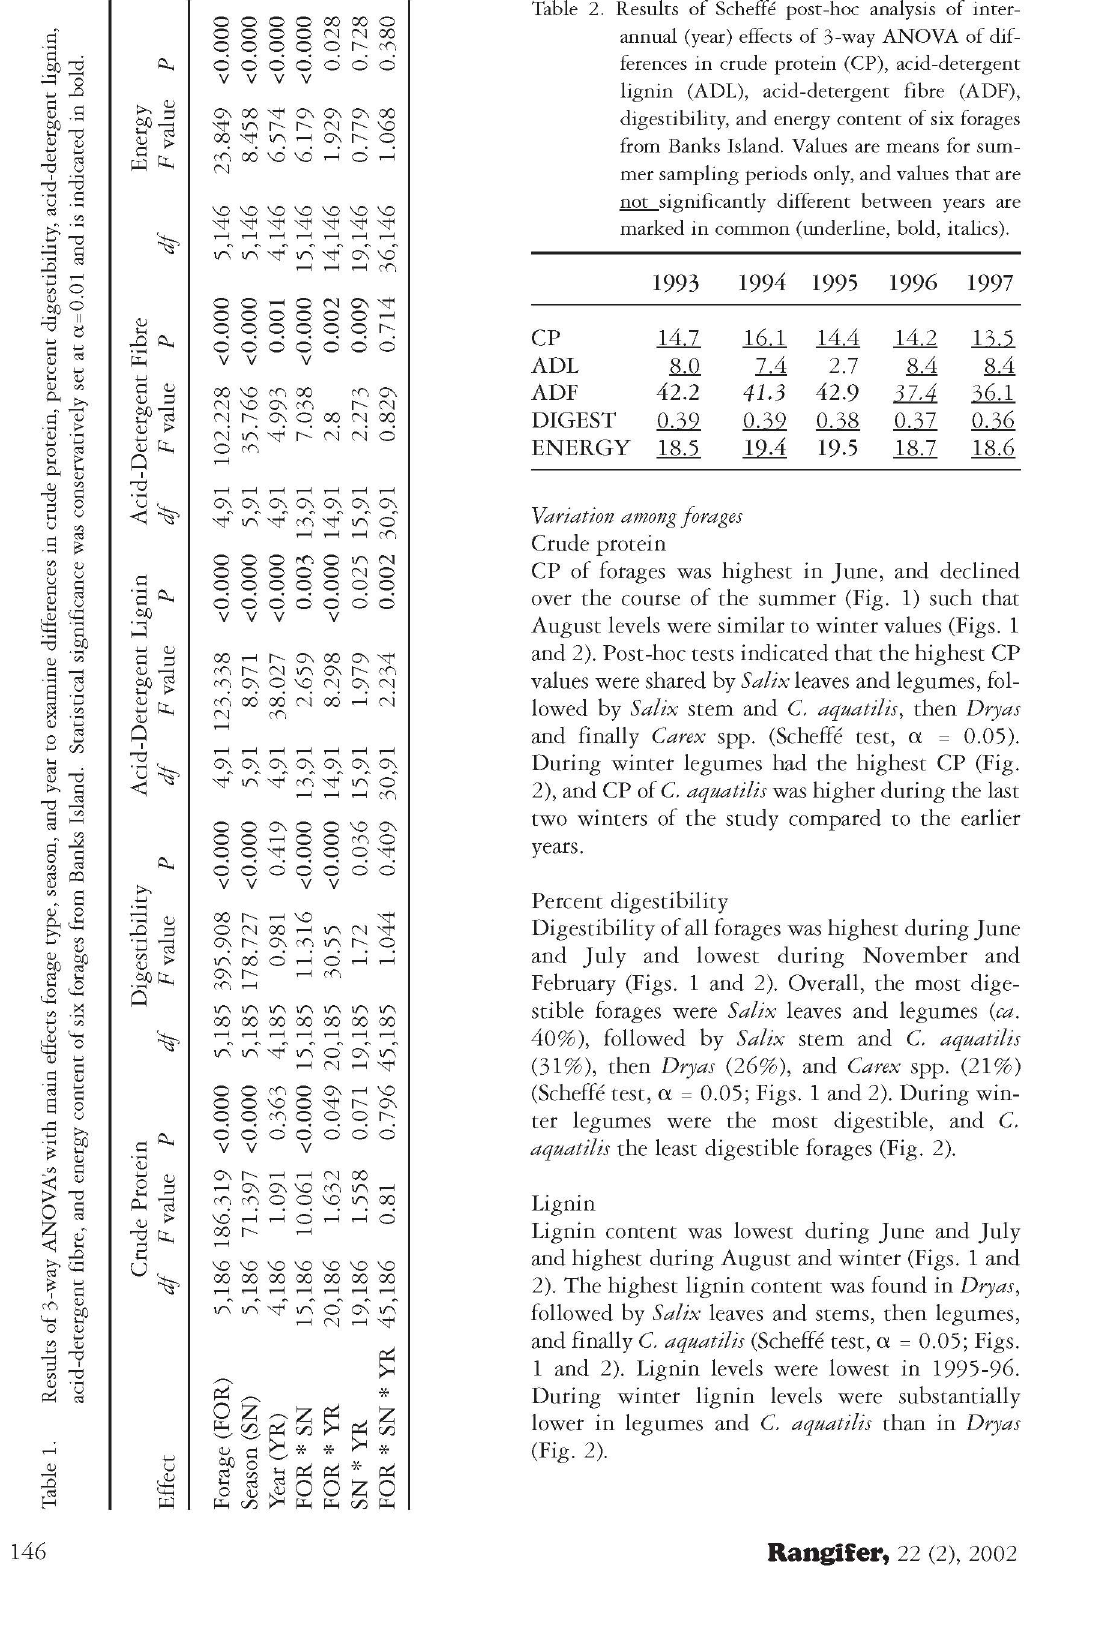
Table 2. Results of Scheffe post-hoc analysis of inter- annual (year) effects of 3-way ANOVA of dif¬ ferences in crude protein (CP), acid-detergent lignin (ADL), acid-detergent fibre (ADF), digestibility, and energy content of six forages from Banks Island. Values are means for sum¬ mer sampling periods only, and values that are not_significantly different between years are marked in common (underline, bold,